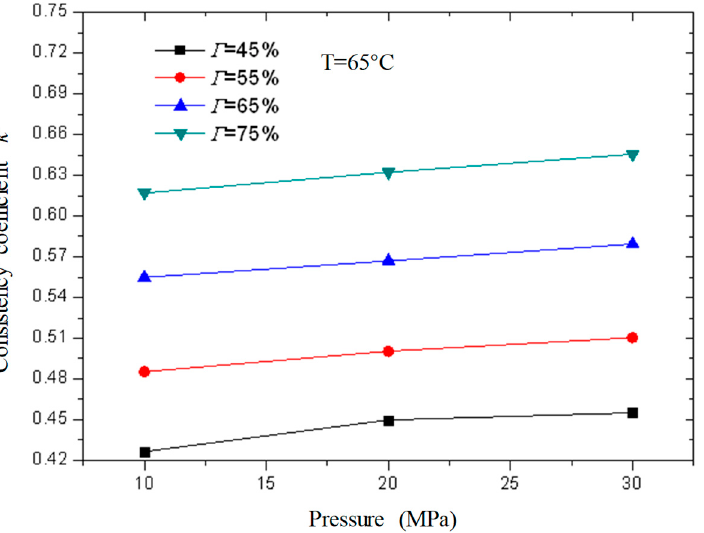
Figure 18. Variation curve of consistency index k of foam gel fracturing fluid with pressure under foaming.